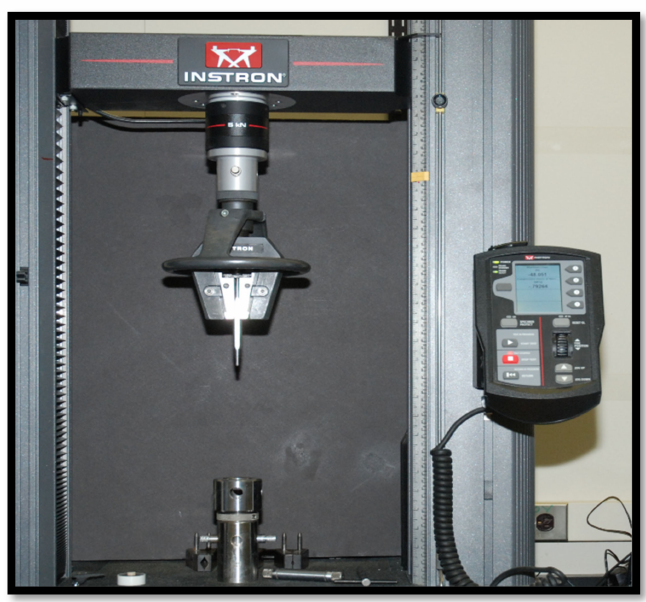
Figure 2. Testing equipment (Instron testing machine) used for denture